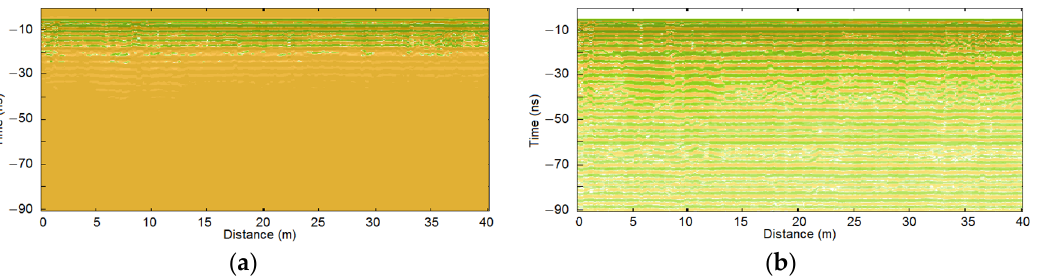
Figure 1. Representation of the logarithm of data: ( a ) before and ( b ) after applying the DC filter.